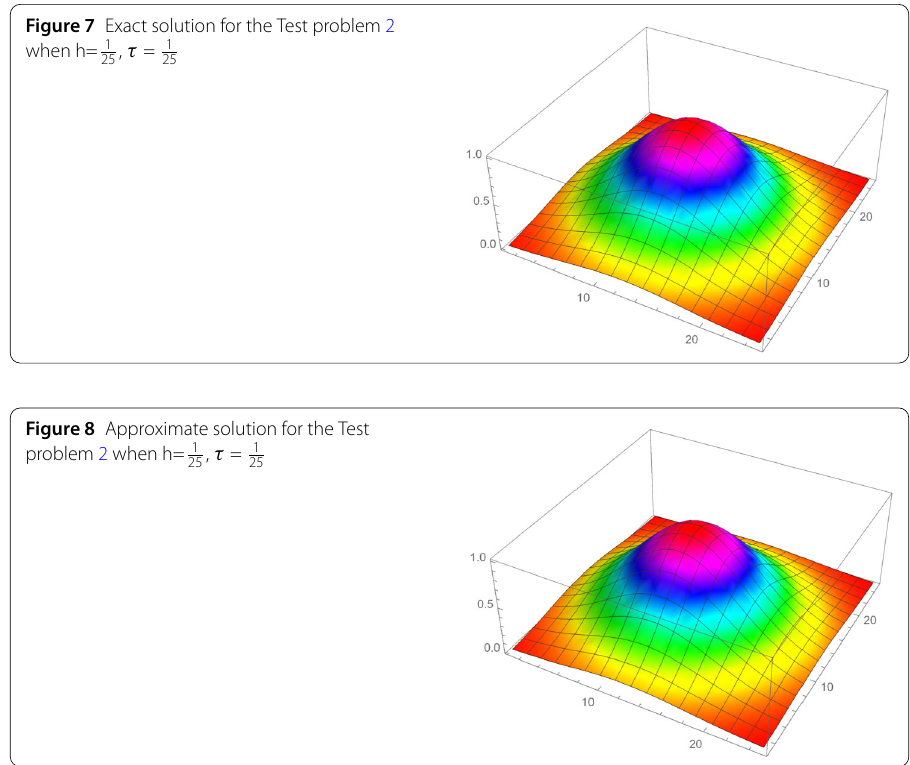
Figure 7 Exact solution for the Test problem 2 when h= 1 , τ = 1 25 25